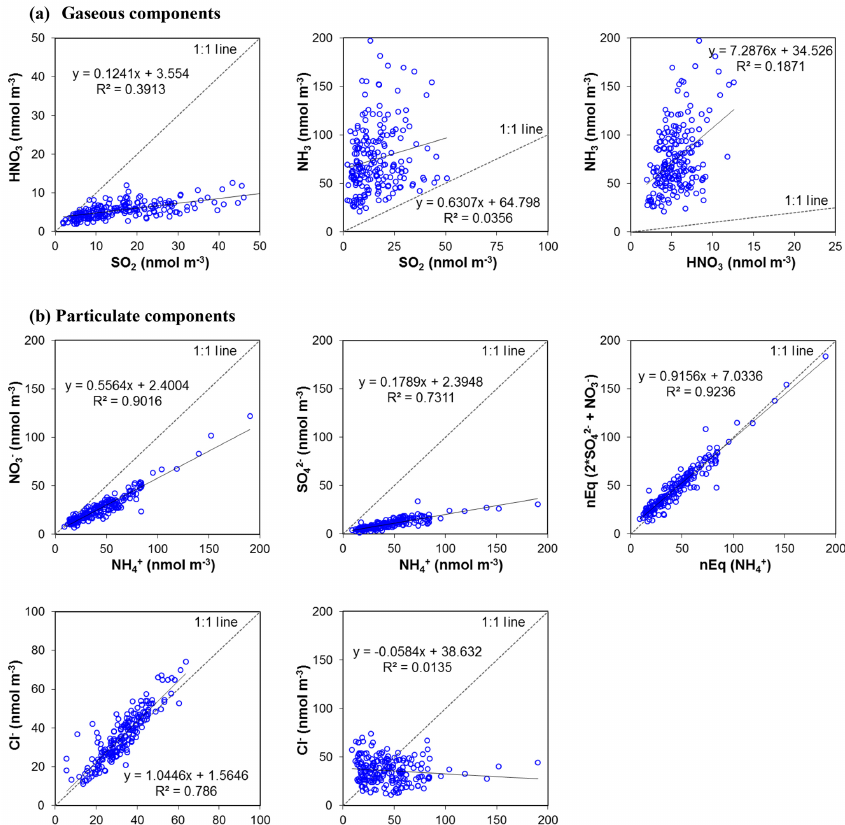
Figure 7. Scatter plots between concentrations of (a) gaseous species HNO 3 , SO 2 , and NH 3 , and (b) particulate species NO − Cl − , and Na + from mean monthly measurements (1999–2015) from the 12 sites in the UK Acid Gas and Aerosol Monitoring Network (AGANet) that were operational over the whole period. NH 3 and NH + (NAMN, Tang et al., 2018) made at the same time. Each data point represents a single monthly DELTA